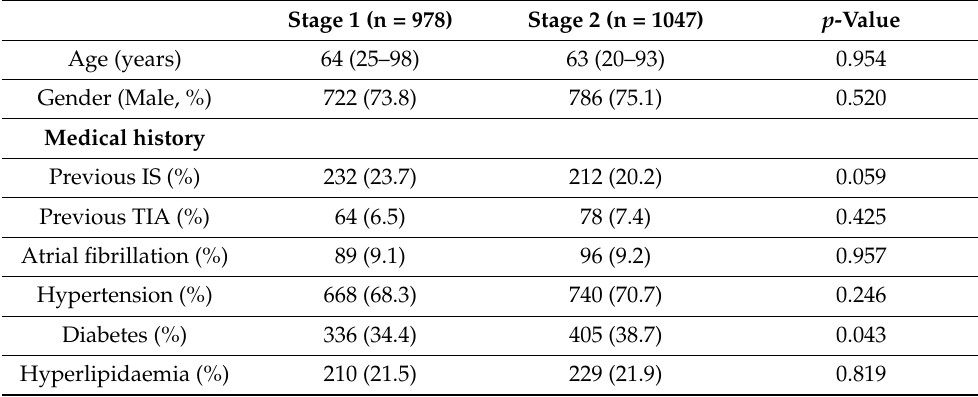
Table 1. Baseline demographics and medical history of the patients in different